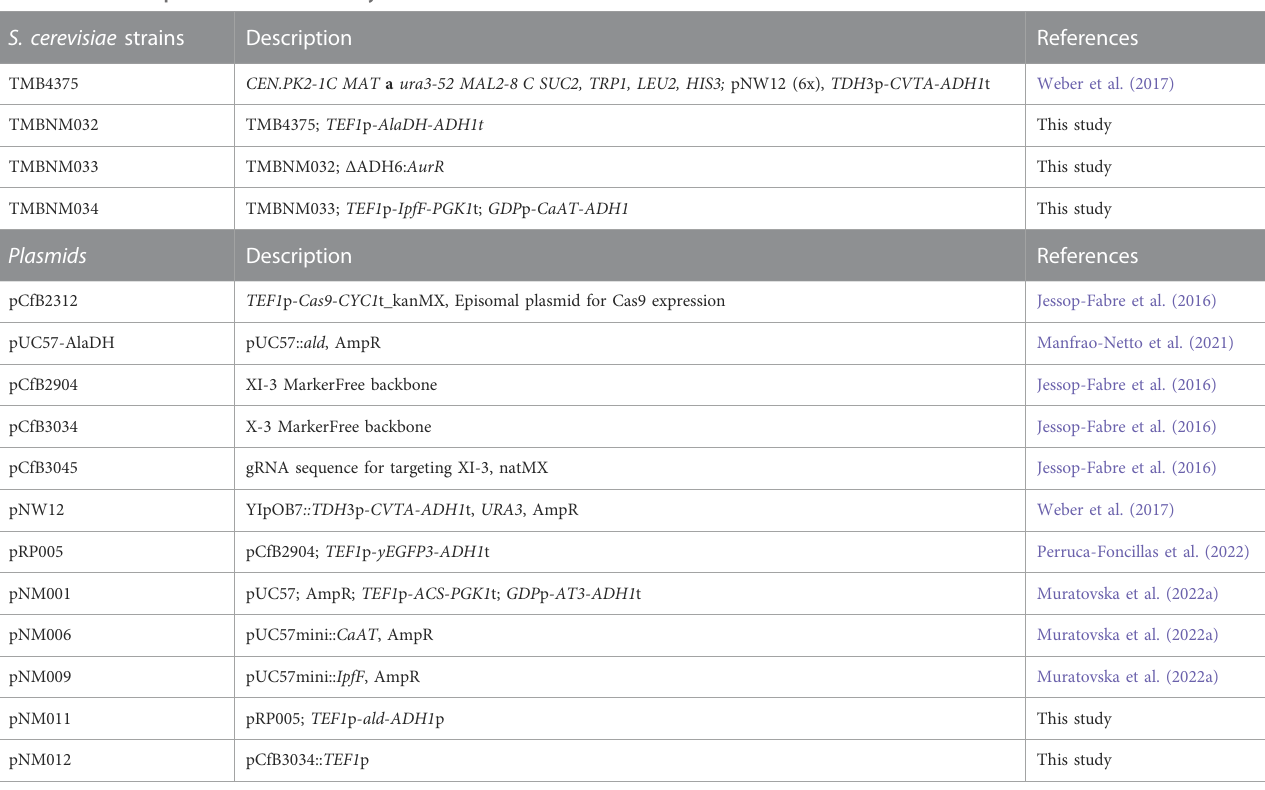
primers listed in Supplementary Table S1. Primers were designed using SnapGene ® (GSL Biotech LLC. Version 3.03, US) and purchased